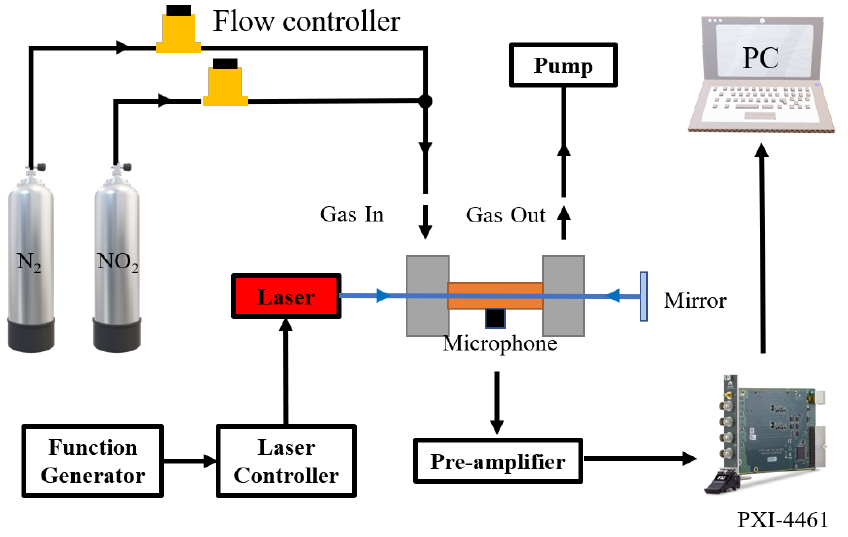
Figure 7. Schematic of the photoacoustic gas measurement